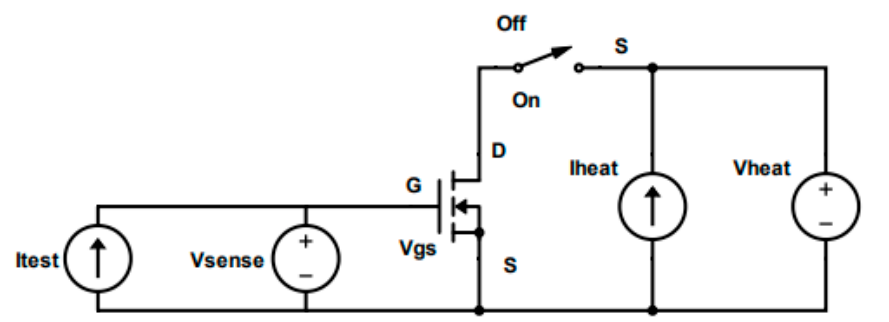
Figure 12. Schematic of the electrical circuit for V gs measurements. The results of the measurement are shown in Figure 13.